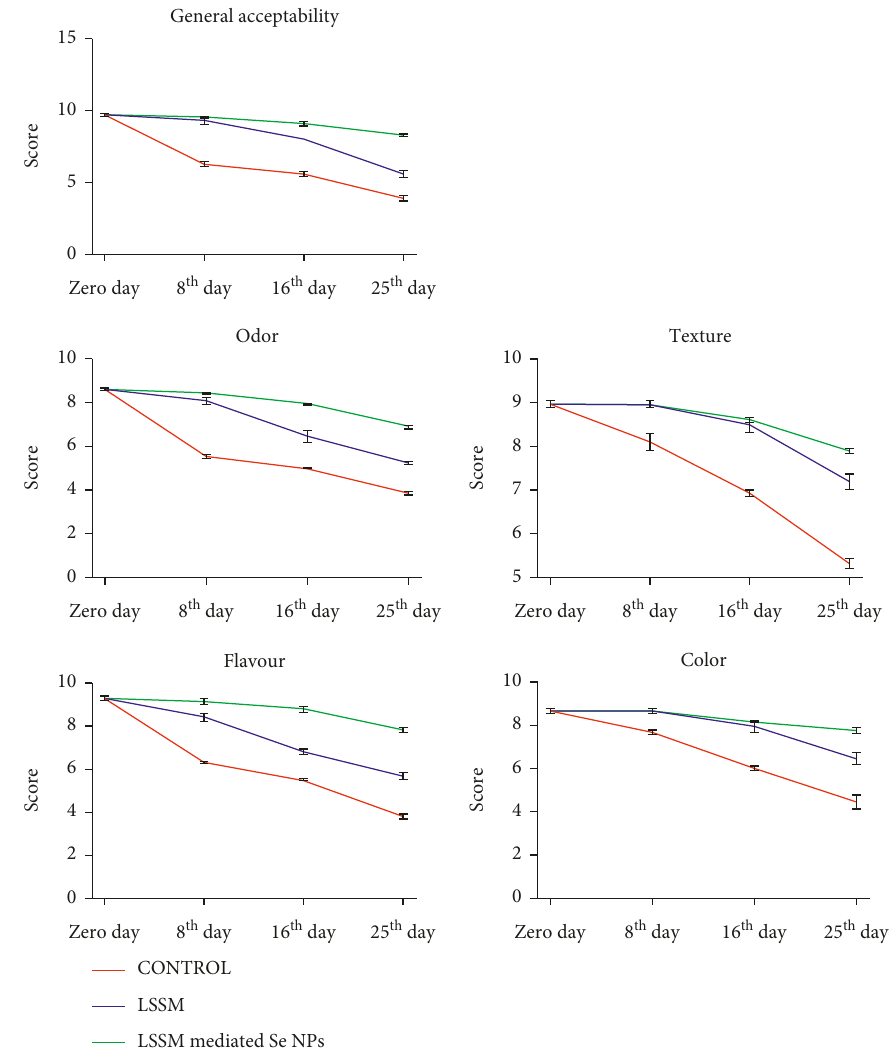
Figure 3: Mean scores of organoleptic characteristics of treated catfish fillets with Lepidium sativum mucilage (LSSM) and LSSM-mediated Se NPs during storage at refrigeration